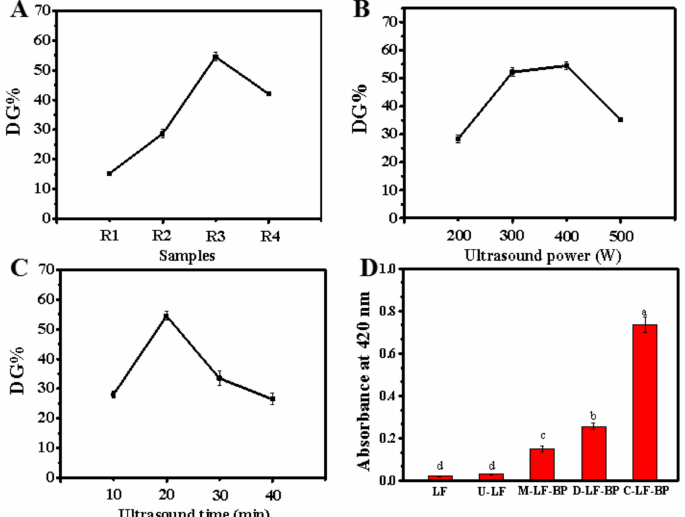
Figure 1. ( A – C ) E ff ects of di ff erent reaction conditions on the degree of graft of LF-BP conjugates. ( A ) LF to BP weight ratio (400 W; 20 min), R1: 2:0.3; R2: 2:0.6; R3: 2:0.9; R4: 2:1.2; ( B ) ultrasound